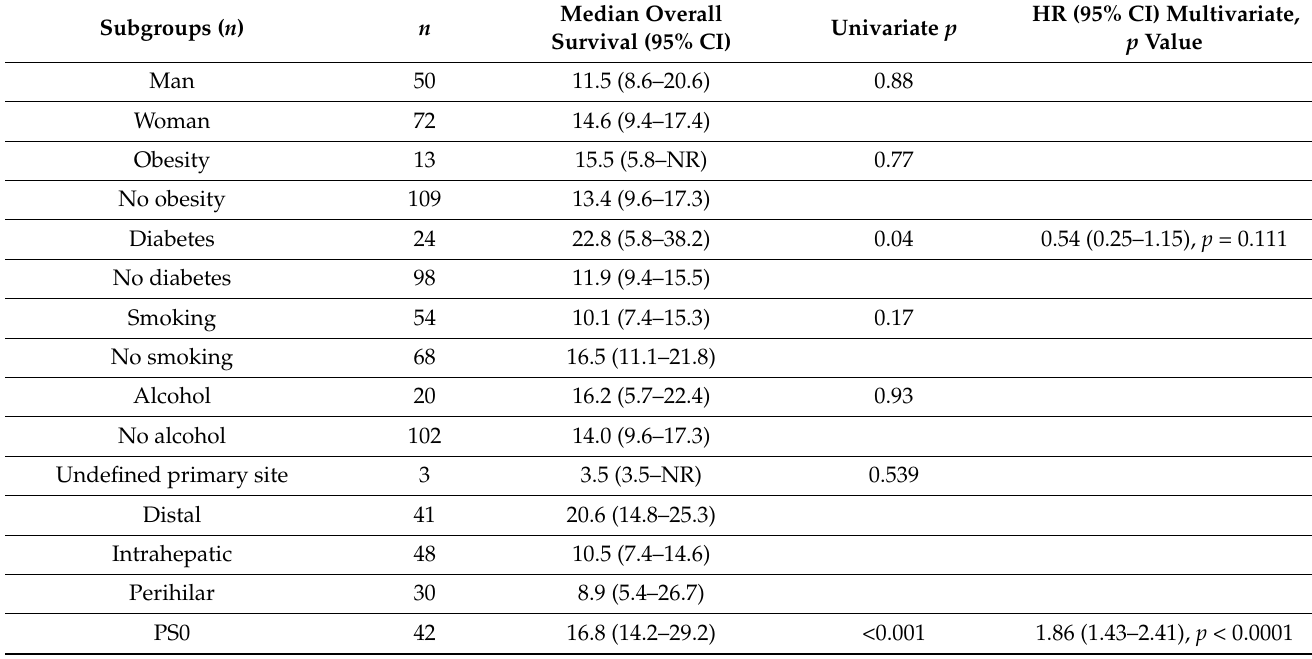
Table 2. Survival by subgroups and uni- and multivariate